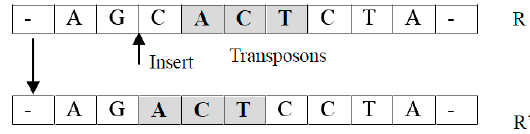
Figure 2. Transposition operation process.